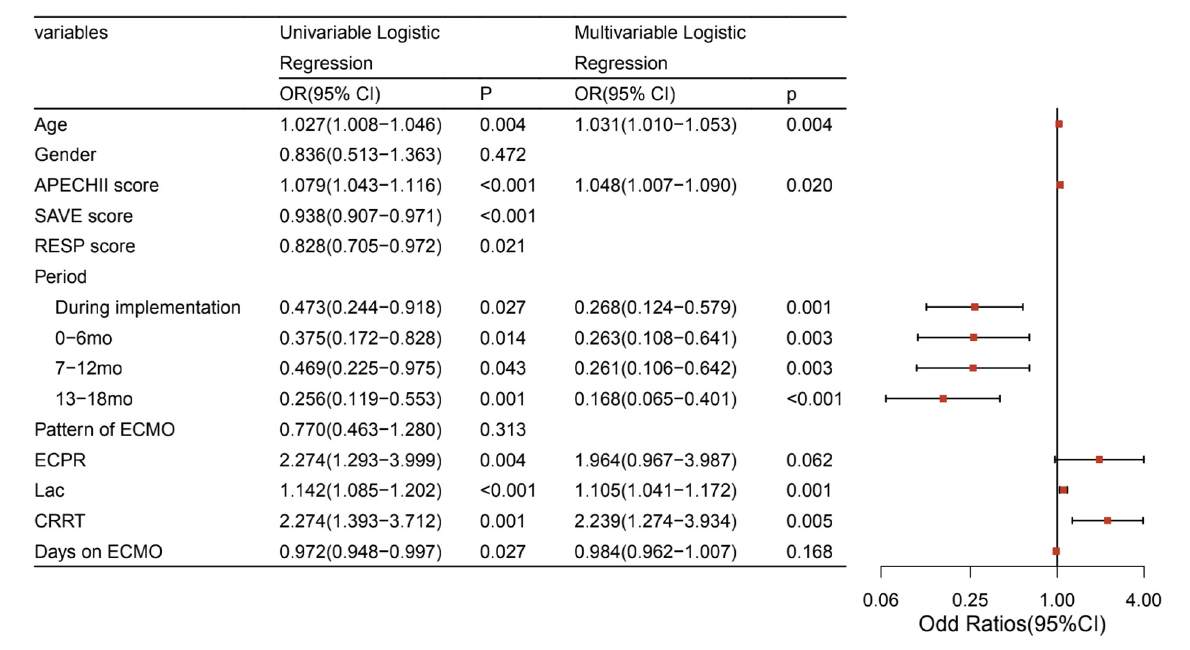
FIGURE2 Factors associated with mortality of ECMO. ECMO, extracorporeal membrane oxygenation; APECHII, acute physiology and chronic health evaluation; SAVE, Survival after VA-ECMO; RESP, respiratory ECMO survival prediction; mo, month; ECPR, Extracorporeal cardiopulmonary resuscitation; Lac, lactate; CRRT, Continuous renal replacement therapy; LOS, length of stay.